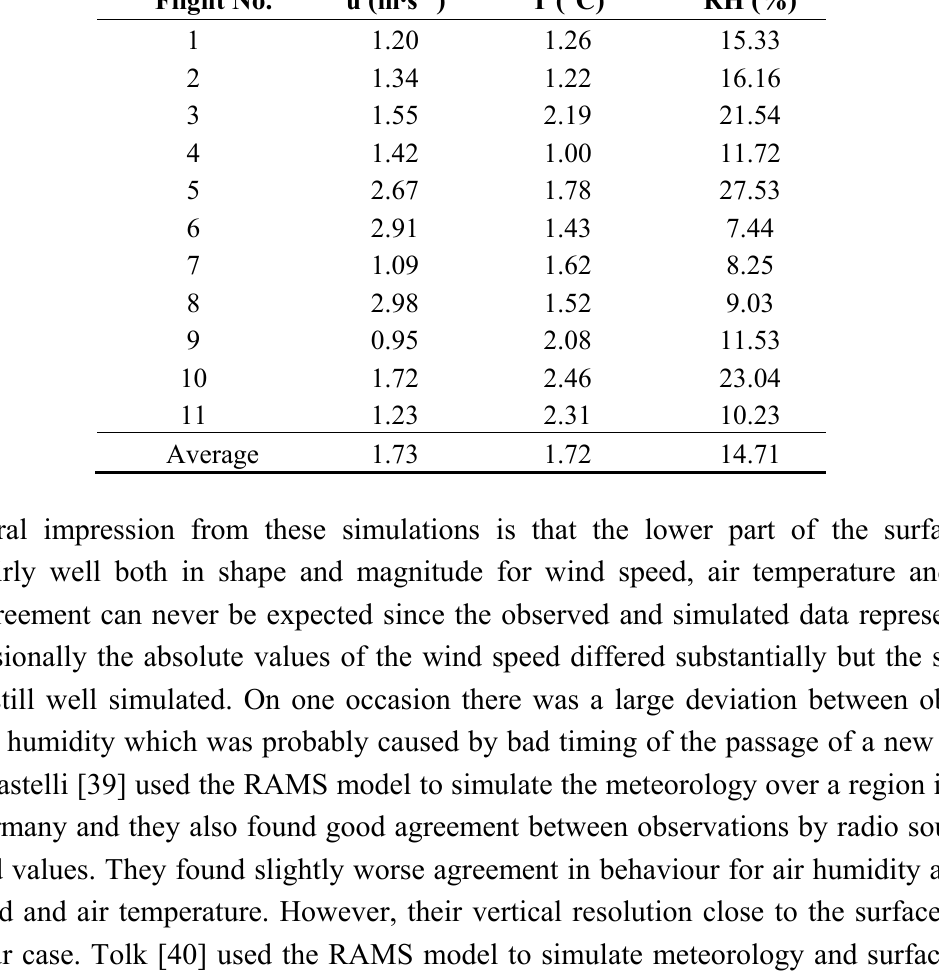
Table 3. Root mean square error (RMSE) per flight estimated from measured and modelled vertical profiles using CORINE land cover data. Symbols are; u = wind speed, T = air temperature and RH = Relative humidity. Flight information is given in Table 2. Flight